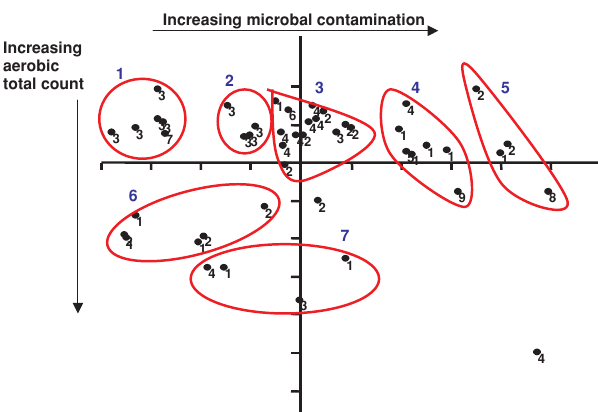
Figure 4. The principal component analysis (PCA) of apple cultivars of organic and integral production, on the basis of their microbial surface contamination (for decoding samples see Table)